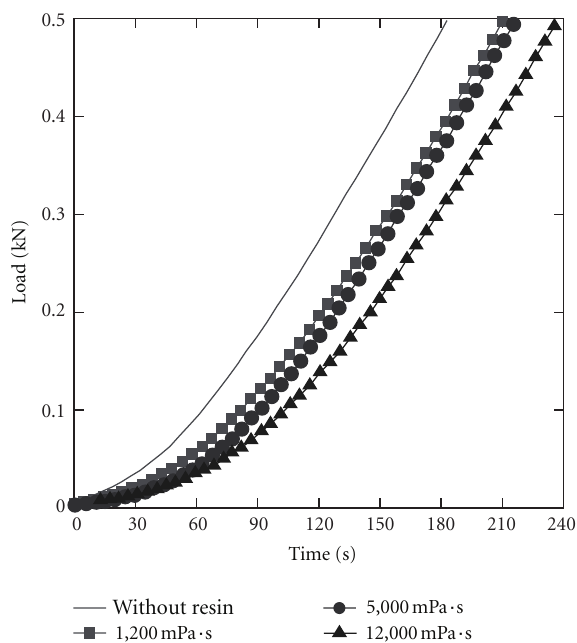
Figure 9: Comparison of nanoimprinting load profiles: the solid line is the reference, the square line is the load profile using low-viscosity resin, the circle line is the load profile using middle-viscosity resin, and the triangle line is the load profile using high-viscosity